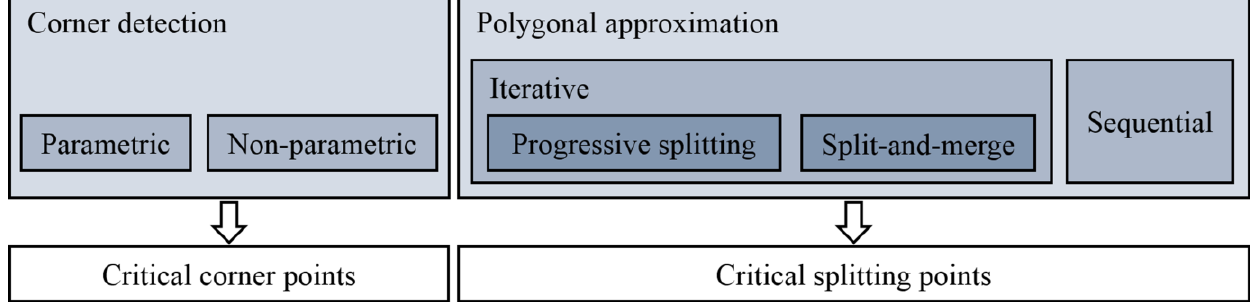
Figure 1. A classification of algorithms for detecting critical